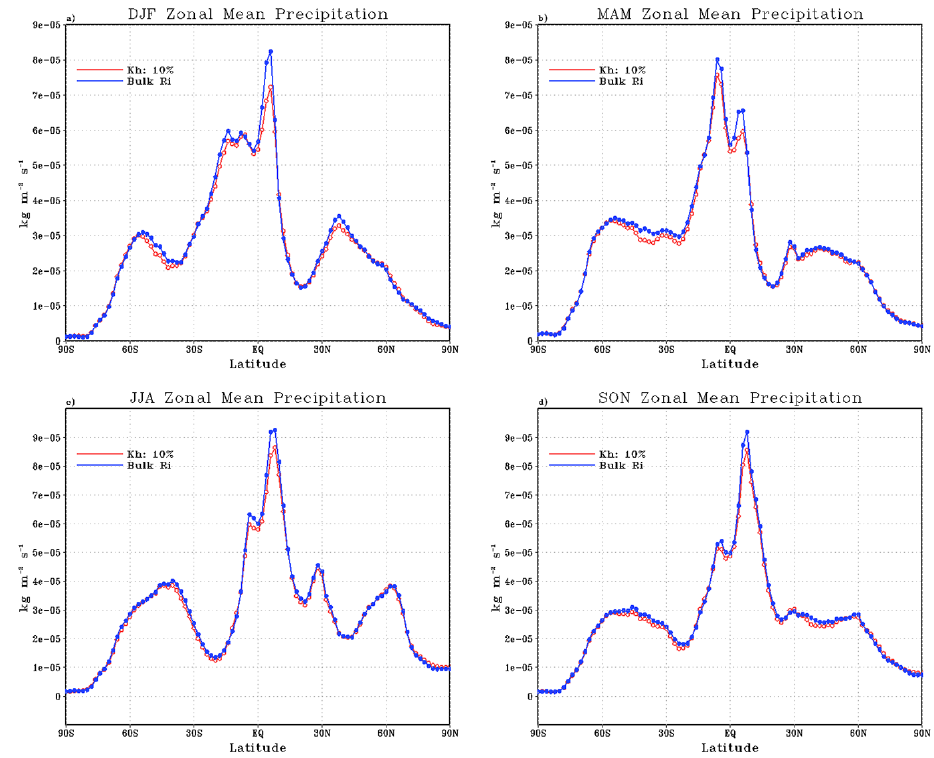
Figure 5. Seasonal mean zonal precipitation for (a) DJF, (b) MAM, (c) JJA, and (d) SON.